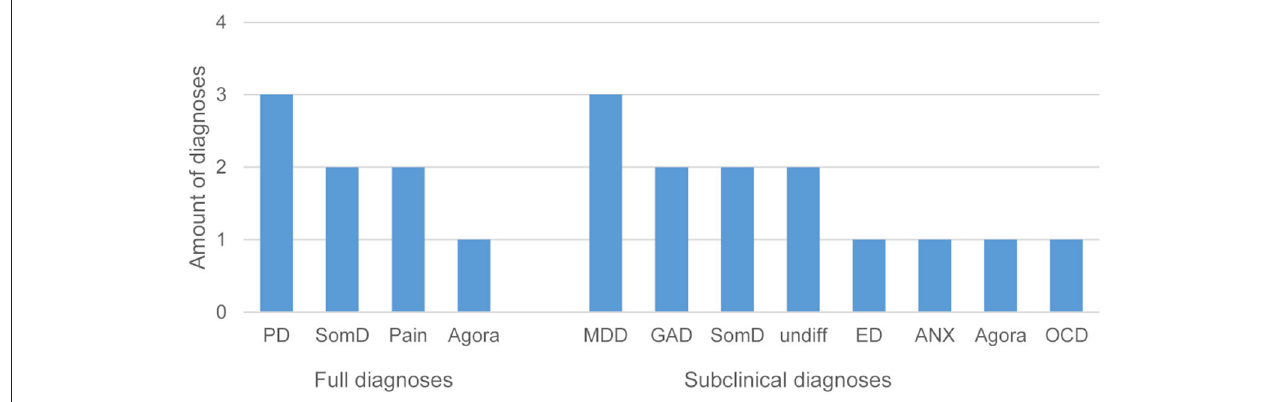
FIGURE 4 | Frequency of fully met and subclinical diagnoses in patients (PD, panic disorder; SomD, somatization disorder; Pain, pain disorder; Agora, agoraphobia without panic disorder; MDD, major depression disorder; GAD, generalized anxiety disorder; undiff, undifferentiated somatoform disorder; ED, eating disorder (binge eating or anorexia nervosa); ANX, anxiety (not otherwise specified); OCD, obsessive-compulsive disorder).